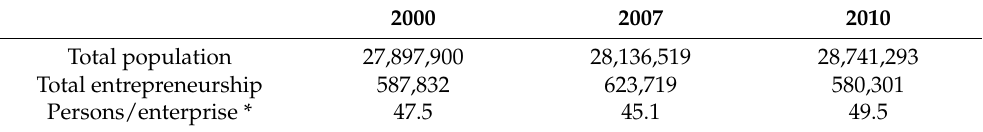
Table 1. Population numbers and total entrepreneurship levels of the 1785 counties for 2000, 2007, and 2010. The year 2000 represents a year during a growth phase of the economy in the United States. The year 2007 represents the end of the growth phase and the onset of a recession. The year 2010 represents the impact of the recession after three